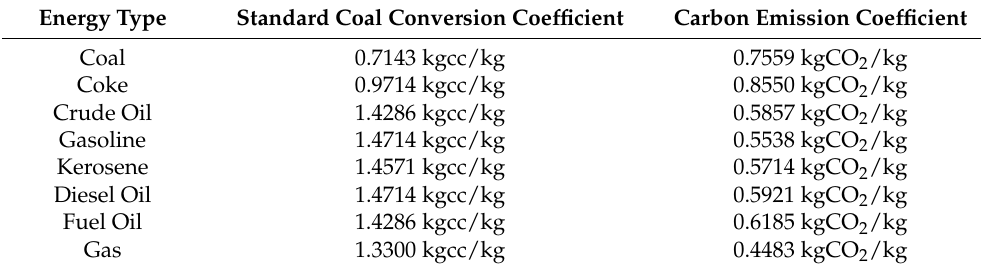
Figure 1. Method flow chart. Table 1. Energy Conversion Standard Coal Reference Coefficient and Carbon Emission